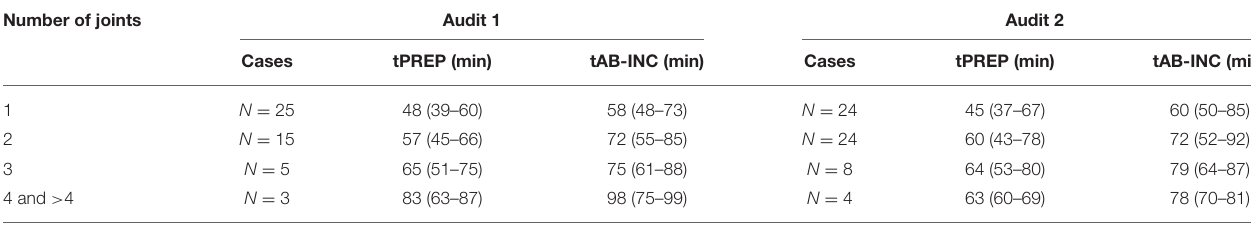
TABLE 1 | Surgical preparation phase (tPREP) and antimicrobial dosing to incision time (tAB-INC) for the elective arthroscopy groups for both the audits. Number of